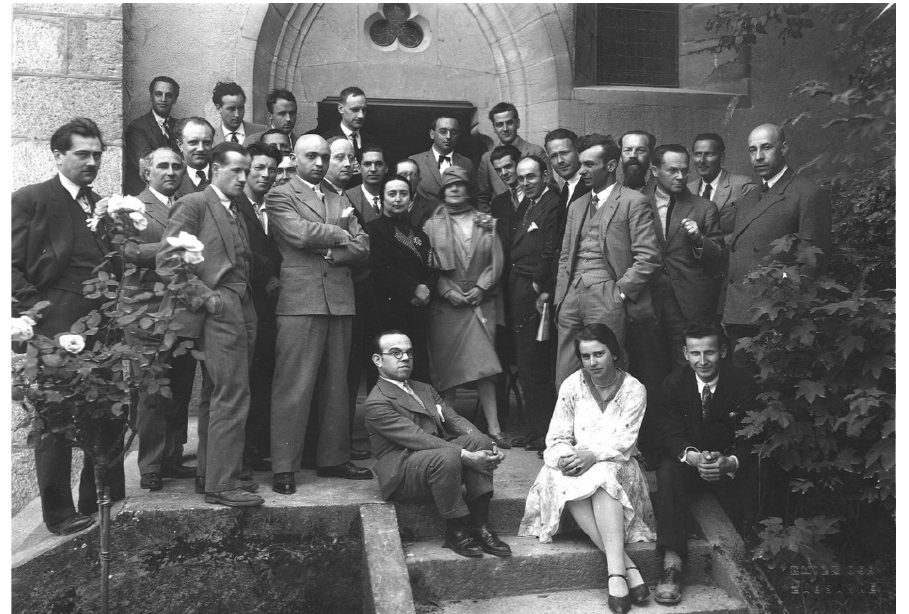
Figure 3. Official group photograph, CIAM I, La Sarraz, 1928. The full list of people in the photo includes, from left to right, top row: M. Stam, M. E. Haefeli, R. Steiger, P. Artaria, F. T. Gubler (press); middle row: R. Dupierreux